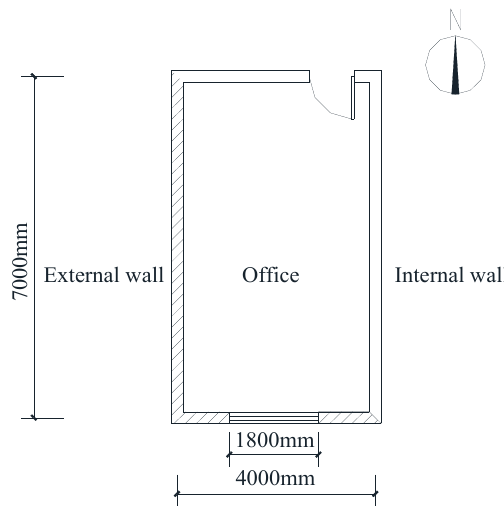
Figure 2. Floor plan of the room studied on every floor. Table 1. Thermal parameters of building envelopes.